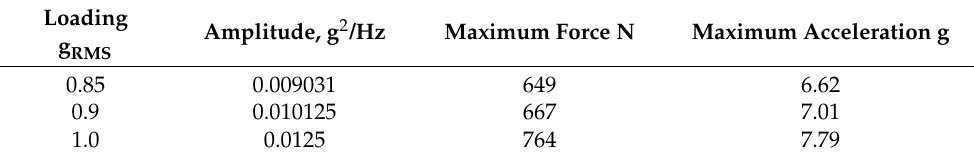
Table 3. Experimental loading conditions for kurtosis Ku =